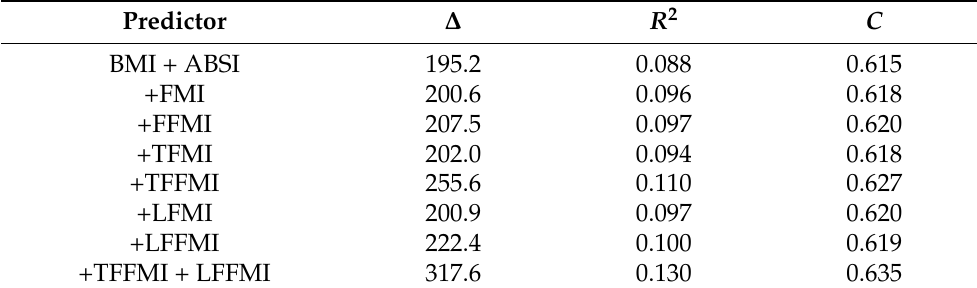
Table 4. The association of each body composition measure with mortality hazard when considered alongside simple anthropometrics.